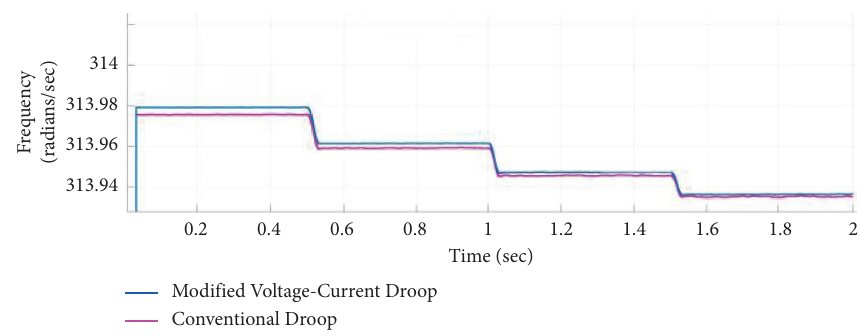
Figure 16: Active power injection of 9 bus microgrid tests system.